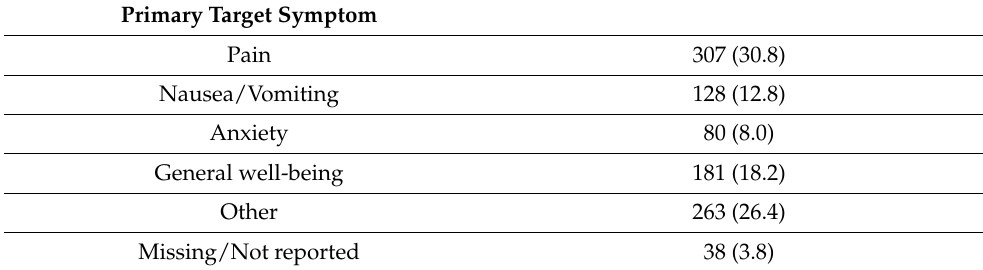
Table 3. Reasons for PIM